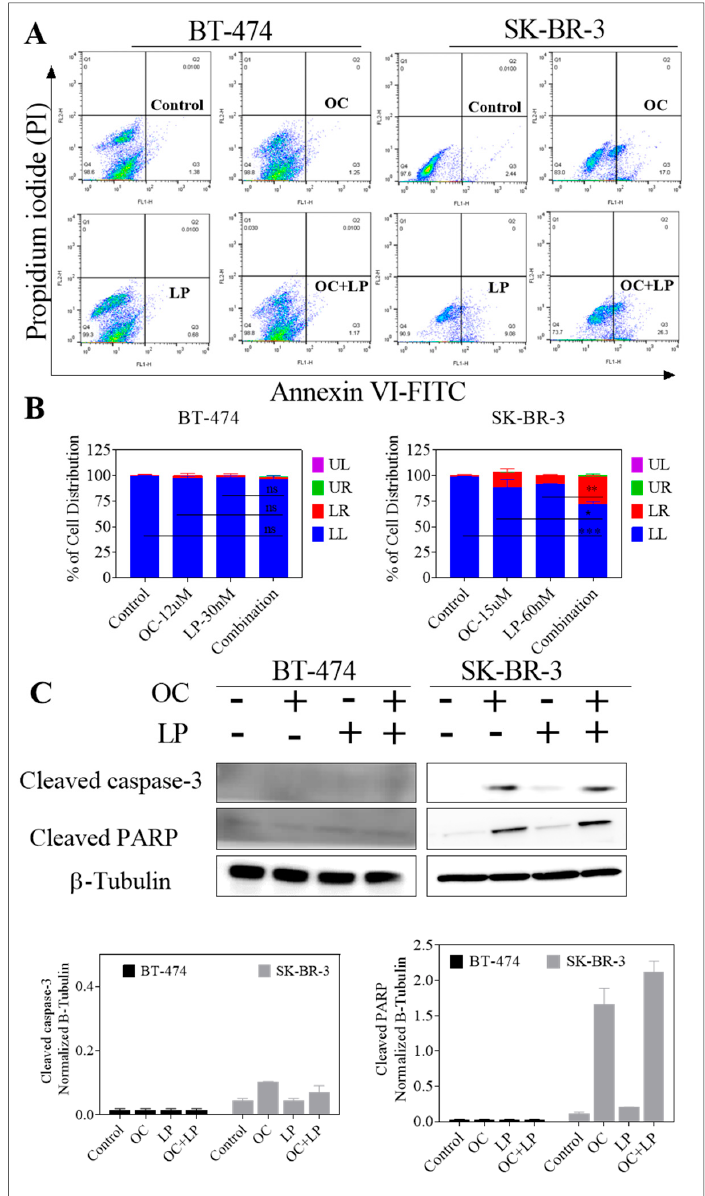
Figure 4. Pro-apoptotic effects of combined OC-LP treatment in HER2-positive BC cells. ( A ) Flow cytometry analysis for OC combined with LP treatment in BT-474 and SK-BR-3 BC cells. Cells were plated at a density of 5 × 10 6 cells/100 mm culture plates, allowed to attach overnight. Afterwards, cells were incubated in the respective control, OC, LP, or LP-OC combination in RPMI-1640 medium containing 40 ng/mL HGF and EGF for 24 h. At the end of the experiment, cells in each treatment group were trypsinized, washed then resuspended in ice-cold 1X Annexin V binding buffer. Afterwards, cells treated as described earlier. In the dot plot of double variable flow cytometry, LL quadrant (FITC − /PI − ) shows living cells; LR quadrant (FITC + /PI − ) represents early apoptotic cells; UR quadrant (FITC + /PI + ) stands for late apoptotic cells and UL quadrant (FITC + /PI + ) stands for necrotic cells. ( B ) Western blot analysis of cleaved caspase 3 and cleaved PARP performed after 24 h incubation. Cells analyzed to examine cell death by measuring cleaved caspase 3 and cleaved PARP detected by Western blotting. In all the above experiments, whole cell lysates were prepared for subsequent separation by polyacrylamide gel electrophoresis followed by Western blot analysis. Imaging and analysis performed as described earlier. * p < 0.05, *** p < 0.001 as compared with either individual OC or LP treatment or vehicle treatment.